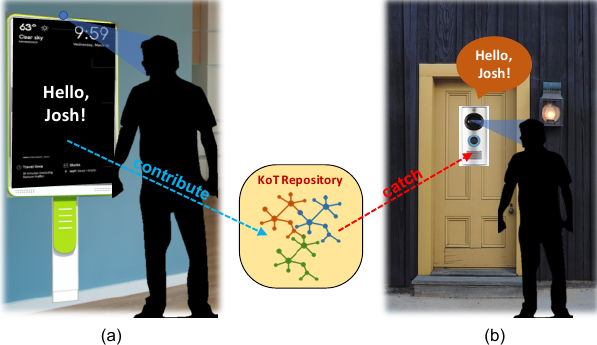
Figure 4. Use case scenario of sharing of self-taught knowledge: face recognition for a smart mirror and a smart doorbell; ( a ) the smart mirror contributes its STK element to a KoT repository and ( b ) the smart doorbell catches the necessary STK element from the KoT repository. (Adapted from [8] with permission of